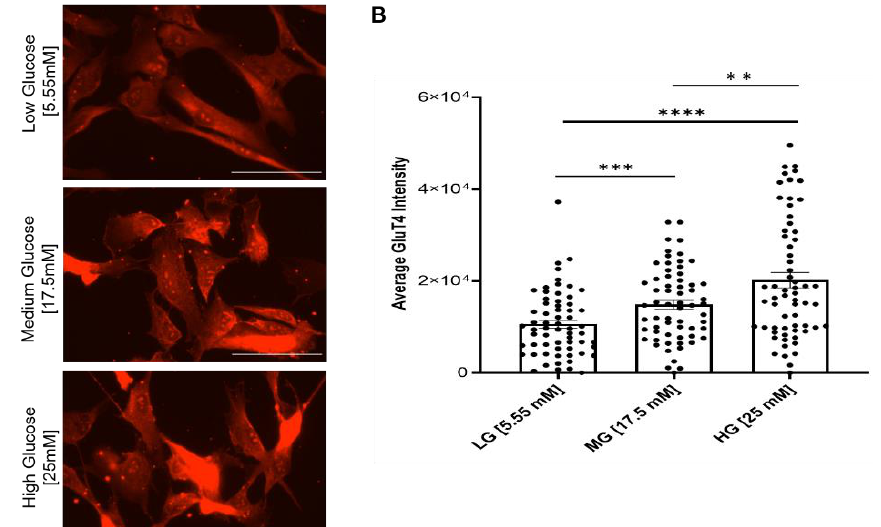
Figure 5. Analysis of Glut4 expression in myoblasts grown under different glucose conditions. ( A ) Immunocytochemical staining of Glut4 on euglycemic (5.55 mM) versus hyperglycemic (17.5 mM, 25 mM) iPSC-derived myoblasts. ( B ) Quantification of average Glut4 intensities at various glucose concentrations. n = 60 cells for each condition from 2 batches of experiment. Error bars = SEM. P ≤